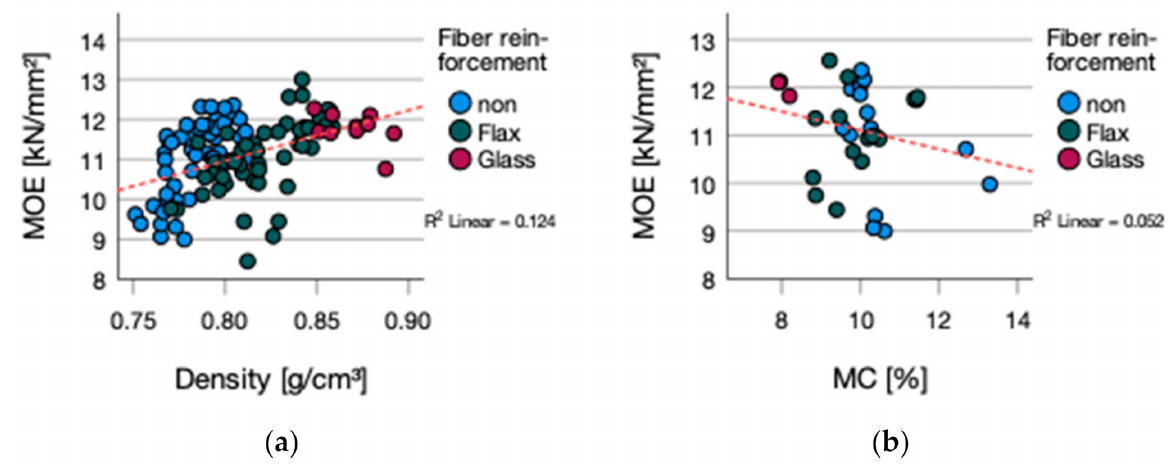
Figure 5. ( a ) MOE vs. density ( b ) MOE vs.